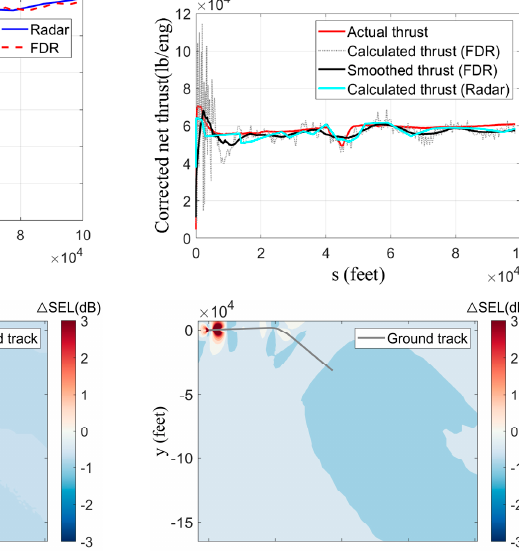
Figure 27. B777 aircraft departing from HKIA (flight BD3). Top: Comparison between the flight profile (left), airspeed (center), calculated and actual thrust (right) inferred from the FDR and radar data. Bottom: Noise contour map, as obtained using FDR data and actual thrust (left). Error entailed by an approximation of the thrust (center: smooth calculated thrust) plus the trajectory estimation (right: radar data, calculated thrust).